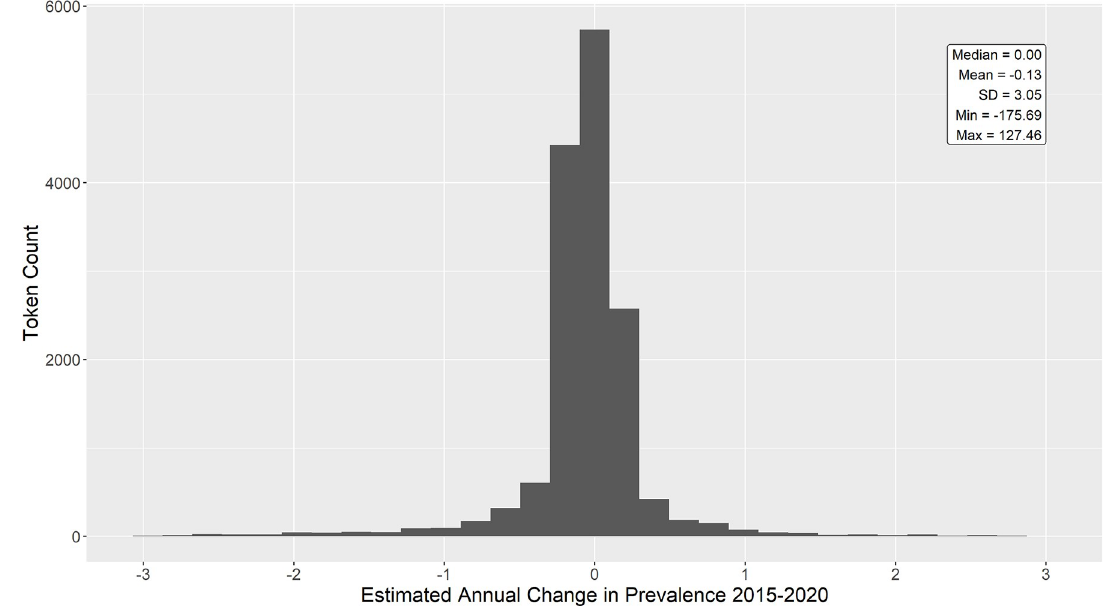
Fig 4. Distribution of estimated annual change in prevalence for all unique tokens within the cross-sectional sample. Prevalence is stable (i.e. zero change) for many tokens. Note from the min and max annotations that extreme values are present in the data but not pictured here. See Tables 6 and 7 for illustration.